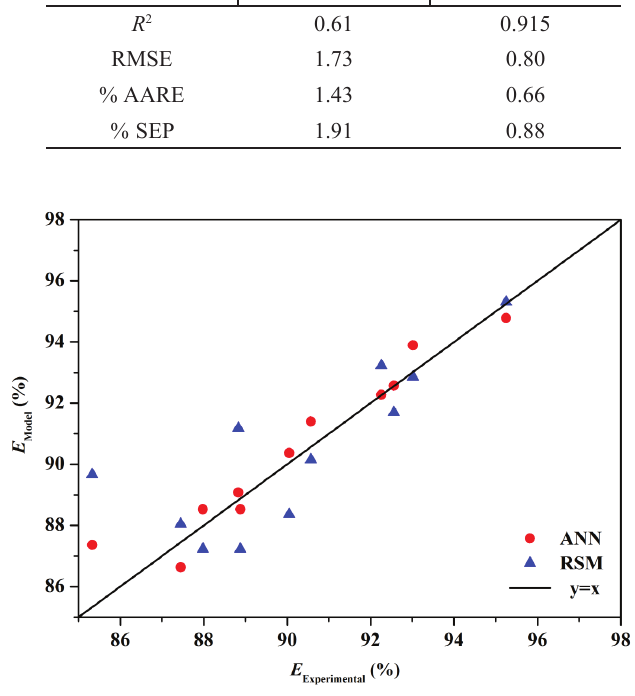
Table 8 – Comparison of RSM and ANN models for its gen- eralization capability (using unseen data) Parameters